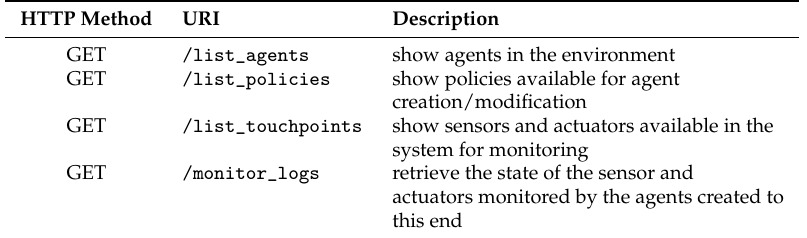
Table 1. REST API for environment.